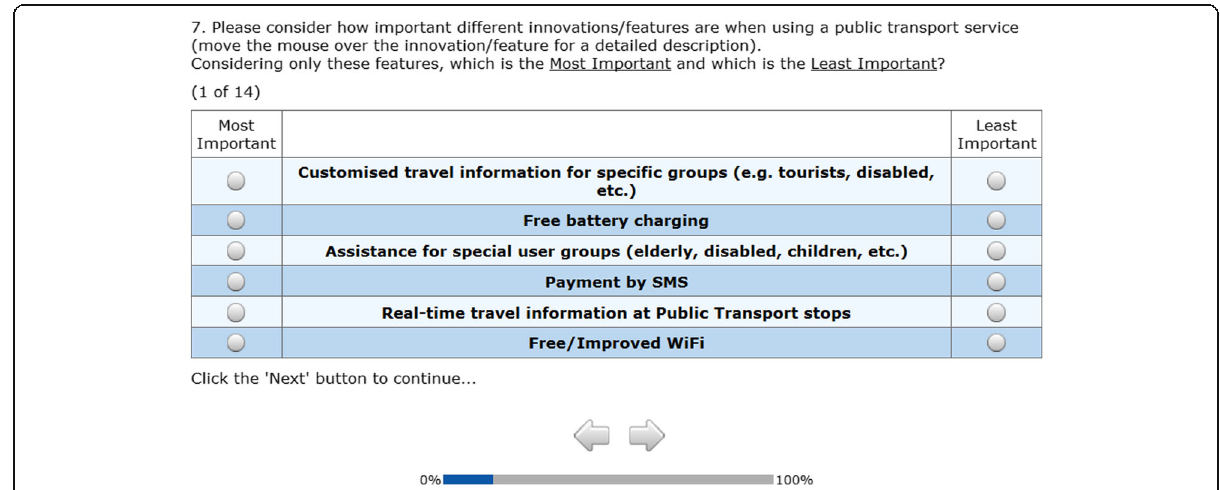
Fig. 1 Sample screen of a MaxDiff